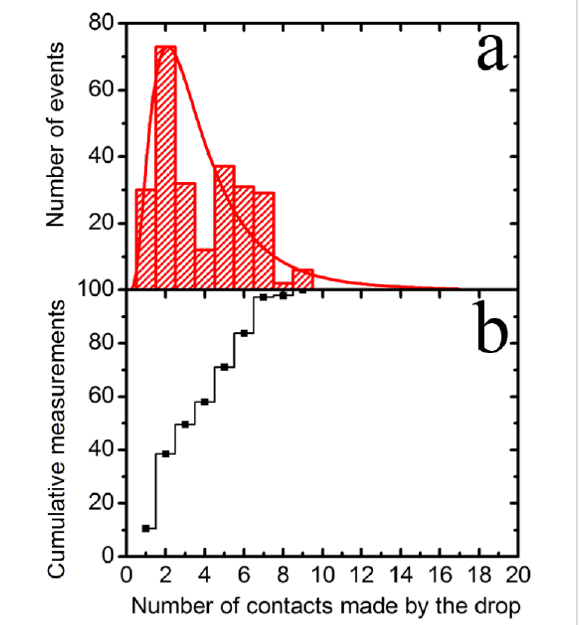
Figure 11: a) Distribution of the number of contacts of the multi-scaled rough diamond surface with the mercury drop for the group with the most data points aligned along a straight line in Figure 9c (dashed line). The red line is a log-normal fit as a guide to the eye, b) Cumula- tive frequency chart of the number of contacts that interacts with the protrusions of the diamond surface.